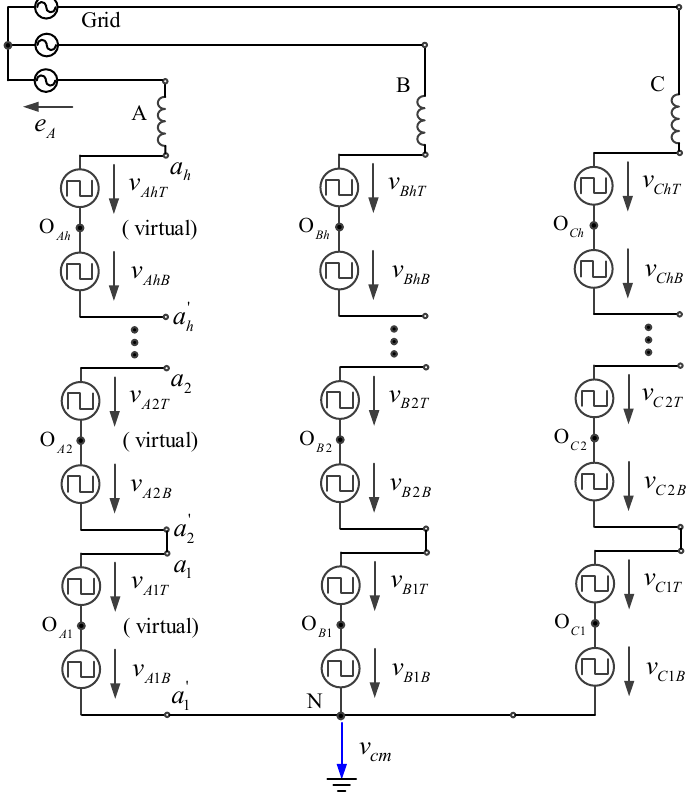
Figure 4. Equivalent circuit for common mode voltage analysis in three-phase CHB-EPT.